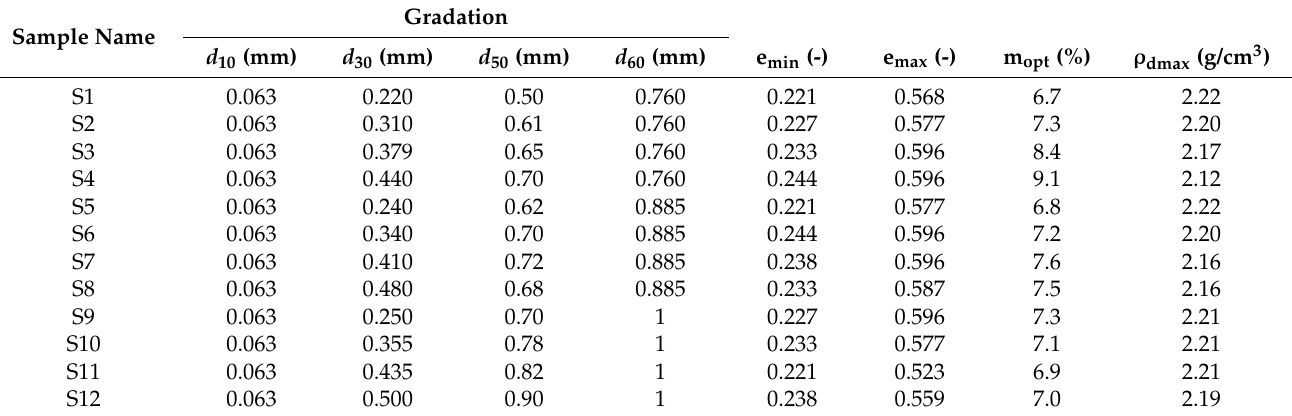
Table 1. Basic properties of the soils tested in the experimental